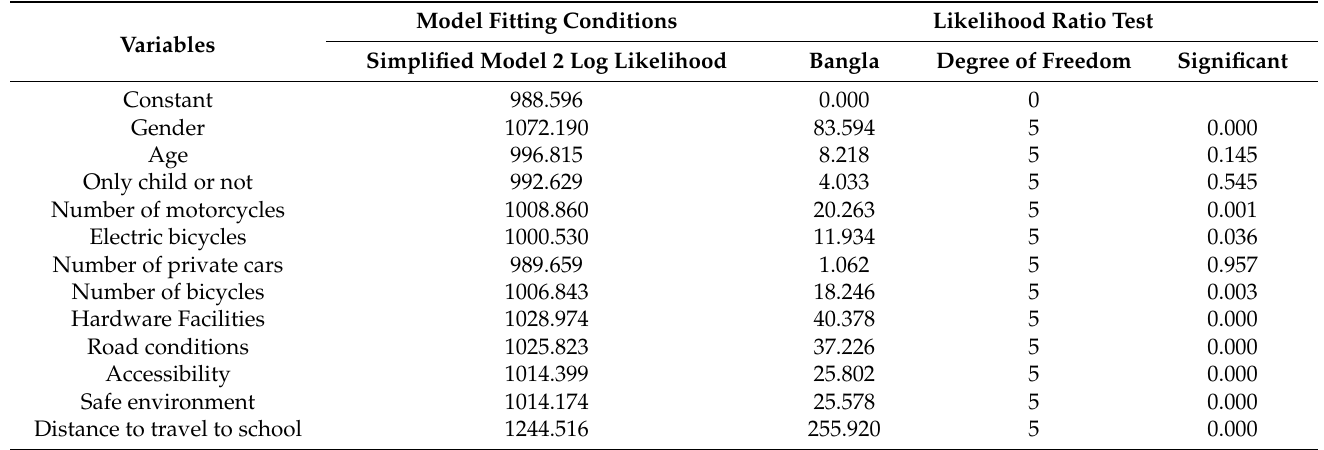
Table 9. Likelihood ratio test for independent variables.